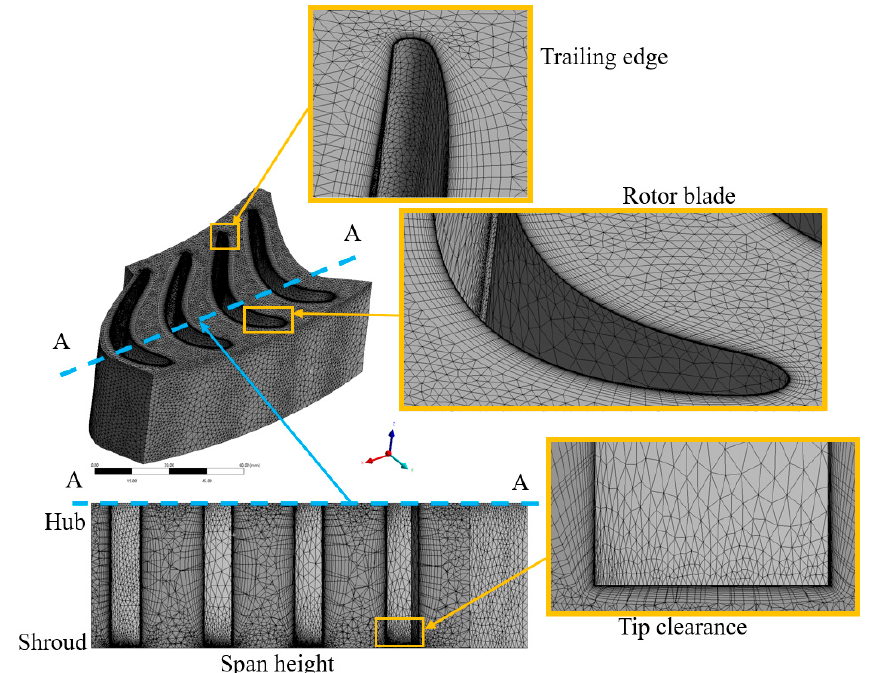
Figure 5. Schematic of the mesh used in the simulations (case 3).